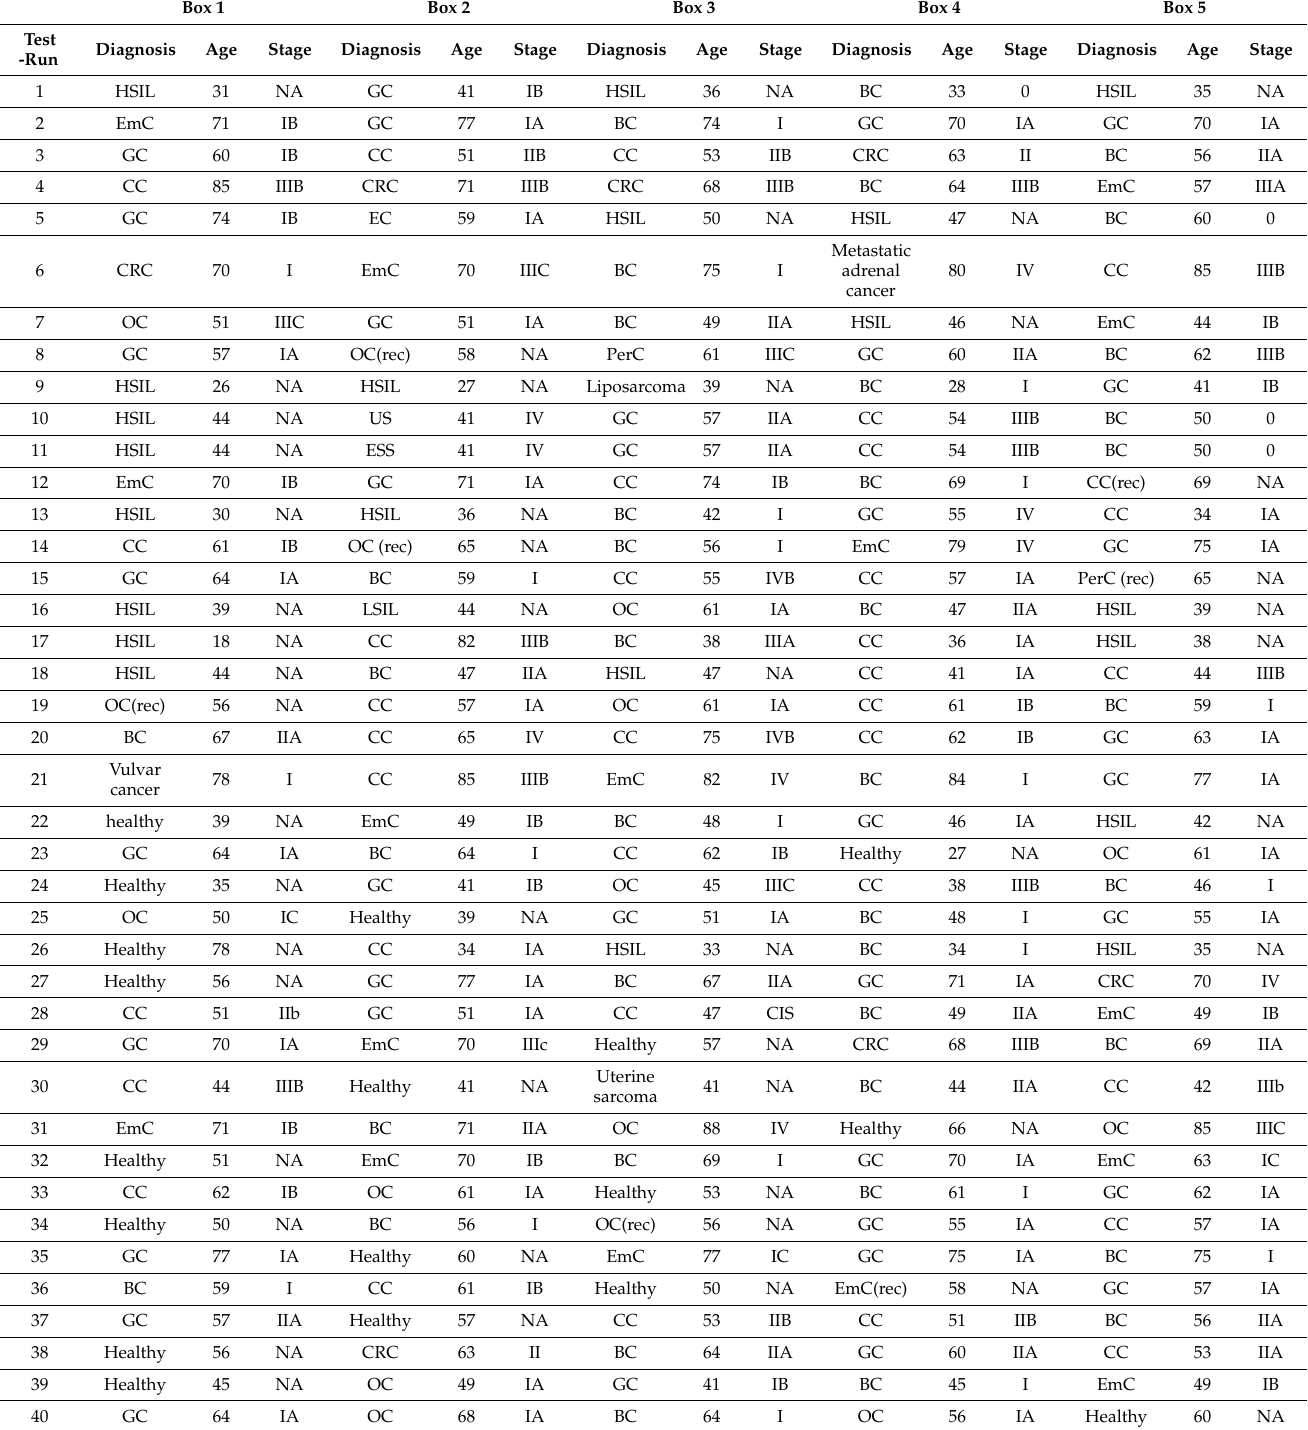
Table 2. Sample combinations of each test-run. Diagnosis/healthy, age, and stage are listed. Stages indicate pathological stage according to UICC